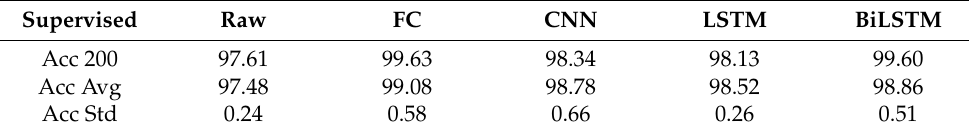
Table 13. Evaluation of the supervised classifier: Accuracy. Supervised